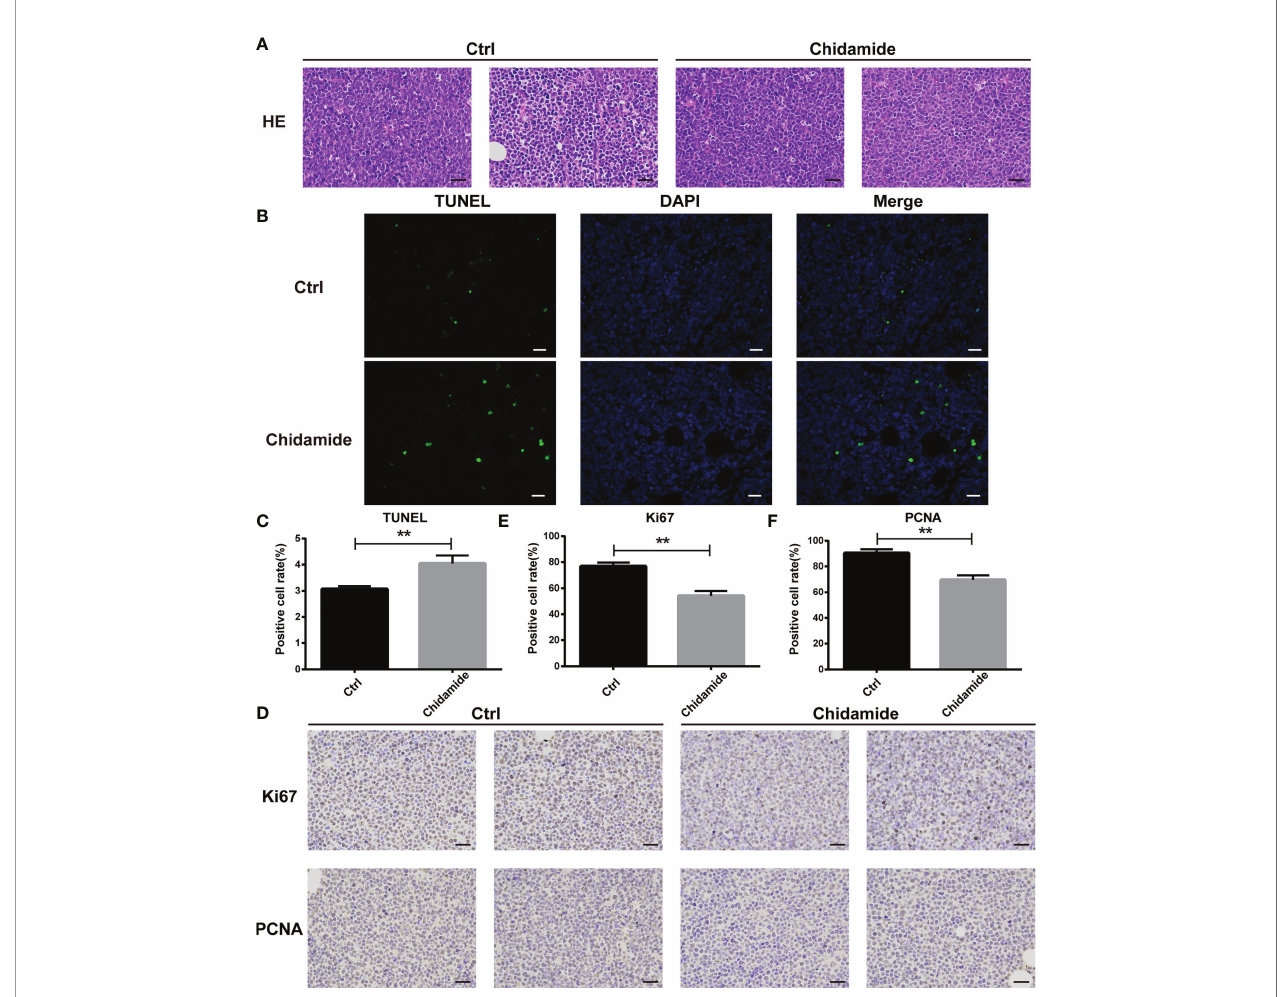
FIGURE 8 | Inhibition of tumor growth in vivo by chidamide. (A) Tumor samples collected after treatment with vehicle/control or chidamide were fi xed, sliced and stained with H&E. (B) Representative images of immuno fl uorescent TUNEL staining performed on serial sections of the tumors are shown; the corresponding statistical results are shown in (C) . Images were acquired under a Nikon microscope (original magni fi cation, ×400). (D) The expression levels of Ki67 and PCNA were detected by immunohistochemical staining. (E, F) Data represent three independent experiments, and are mean±S.D. (** p <